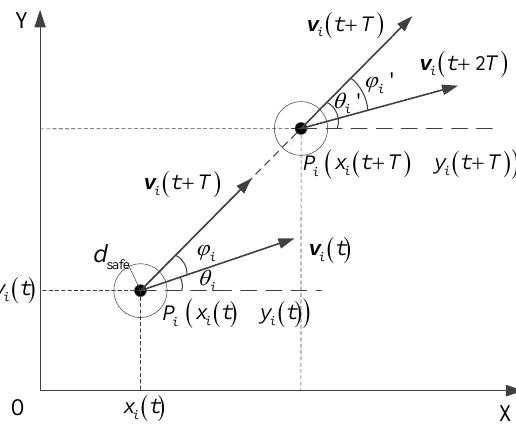
Figure 2. The schematic diagram of the movement of